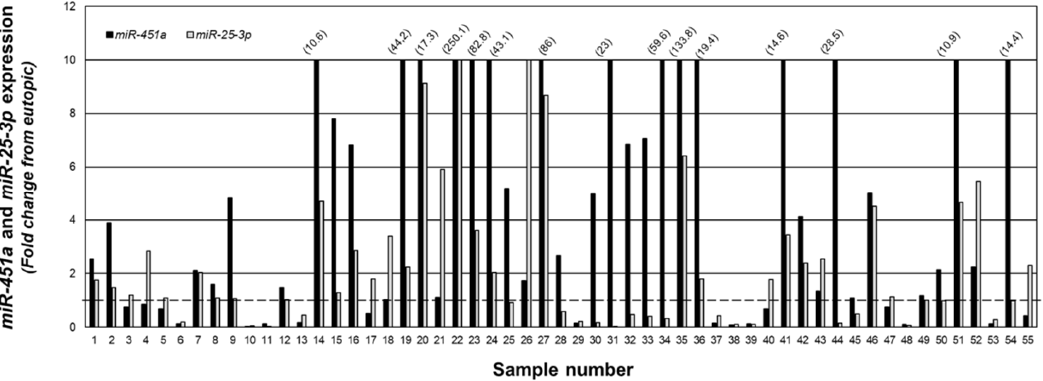
Figure 4. Fold change in miR-451a and miR-25-3p expression in peritoneal endometriotic lesions. Data are expressed as the fold change from eutopic endometrial levels for miR-4541a and miR-25-3p in the same sample. Numbers in parenthesis reflect actual fold change increase for miR-451a in specified sample number. The fold change was capped at 10 to allow depiction of ratios below 1.0 (indicated by broken line).